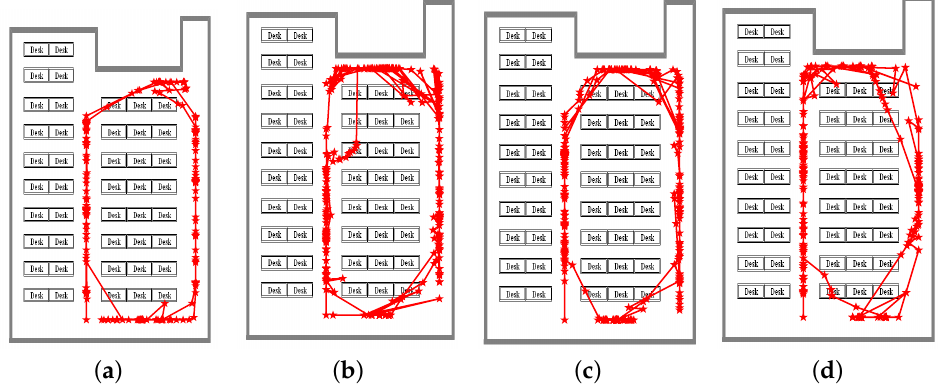
Figure 9. Positioning results for DR/MM in study room: ( a ) calling; ( b ) dangling; ( c ) handheld; and ( d )